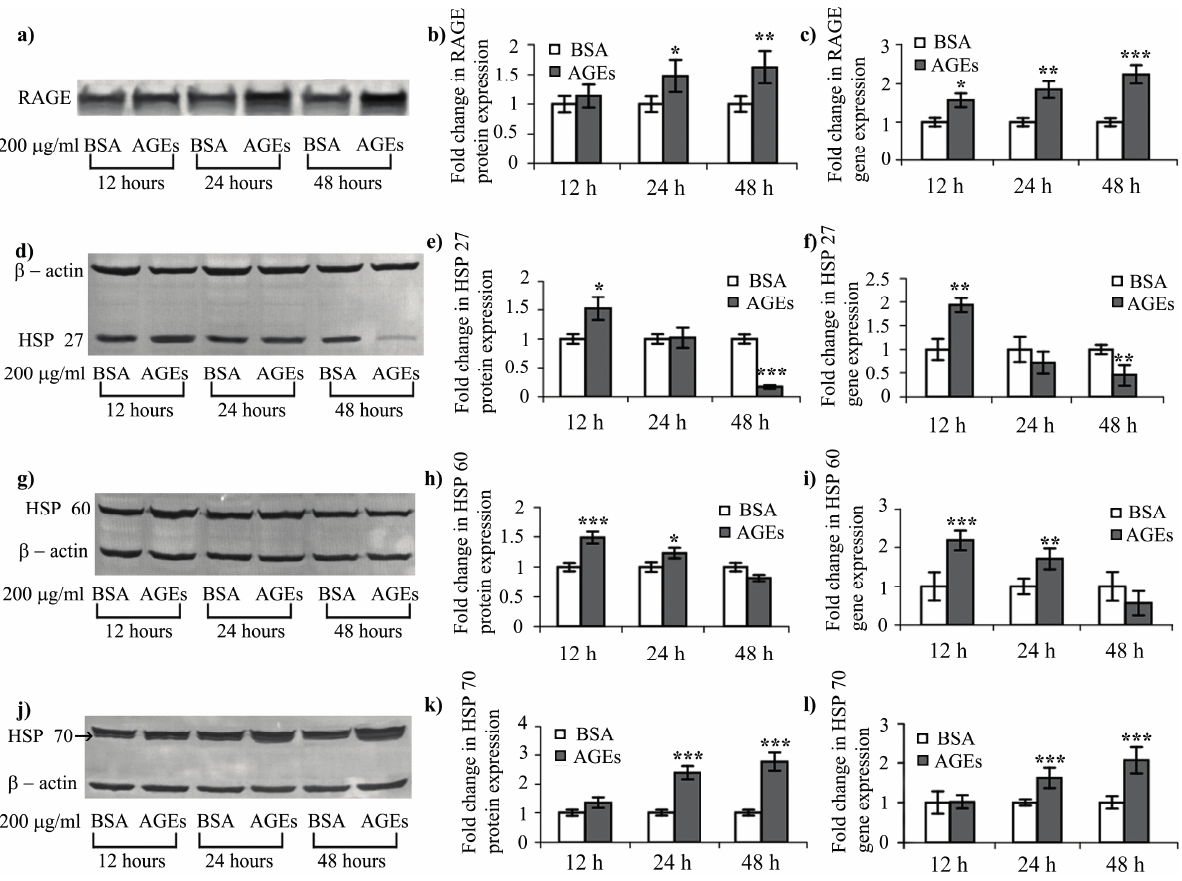
Figure 2. Gene and protein expression of AGEs receptor (RAGE) and heat shock proteins modulated by AGEs ( a , d , g , j ) Representative blotted membranes indicating RAGE, HSP 27, HSP 60 and HSP 70 protein expression; ( b , e , h , k ) Combined densitometry data of three blotted membranes indicating fold changes in protein expression of RAGE (reported to total proteins loaded), HSP 27, HSP 60 and HSP 70 (reported to β -actin); ( c , f , i , l )-relative expression ratio of RAGE , HSP 27 , HSP 60 and HSP 70 target genes ( GAPDH , housekeeping gene). HSP: heat shock protein; * p < 0.05; ** p < 0.01; *** p <